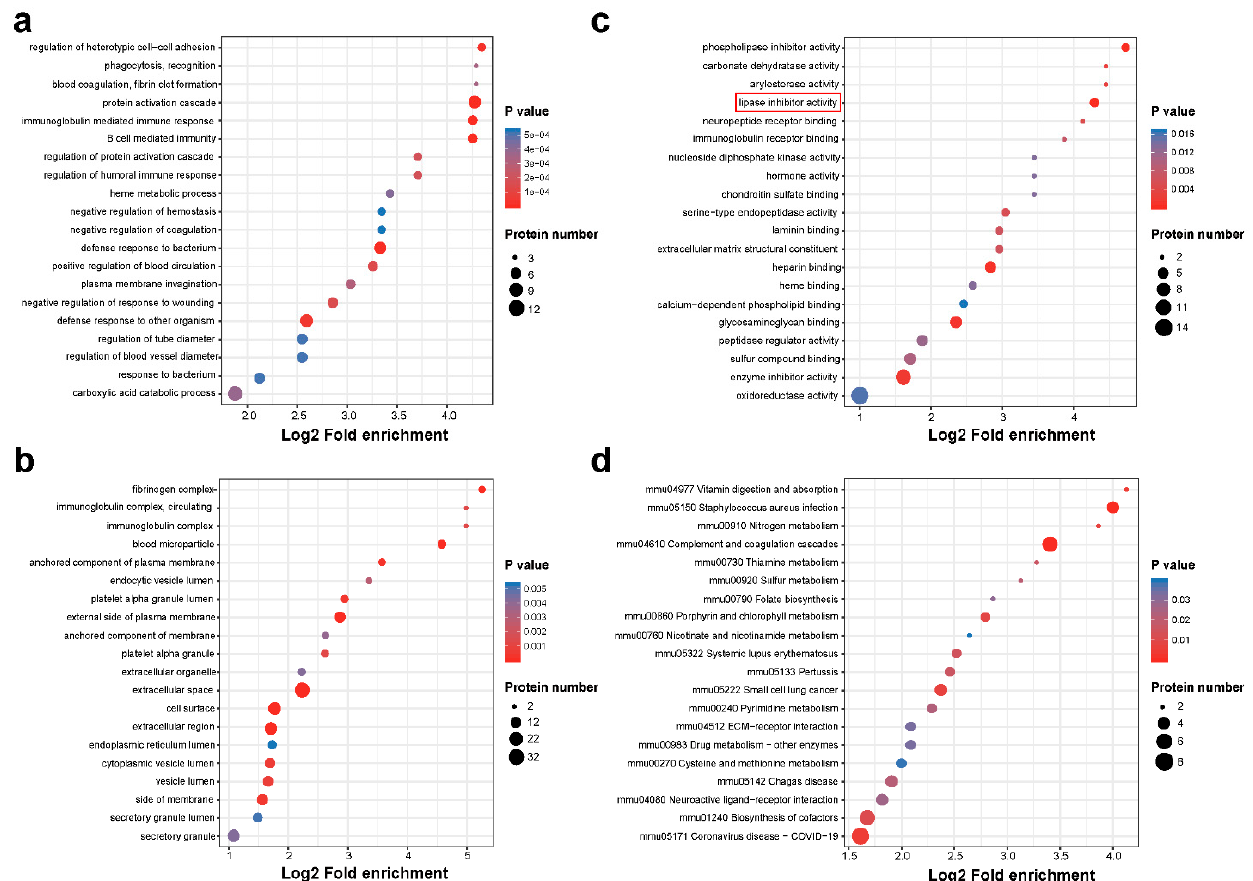
Figure 3. Functional enrichment analysis of differential proteins. The abscissa indicates log2 fold enrichment and the ordinate indicates different GO terms or KEGG pathways. The redder the circle, the smaller the p -value, and the larger the circle, the more proteins that are represented. ( a ) GO biological process enrichment analysis. ( b ) GO cellular component enrichment analysis. ( c ) GO molecular function enrichment analysis. ( d ) KEGG pathway enrichment